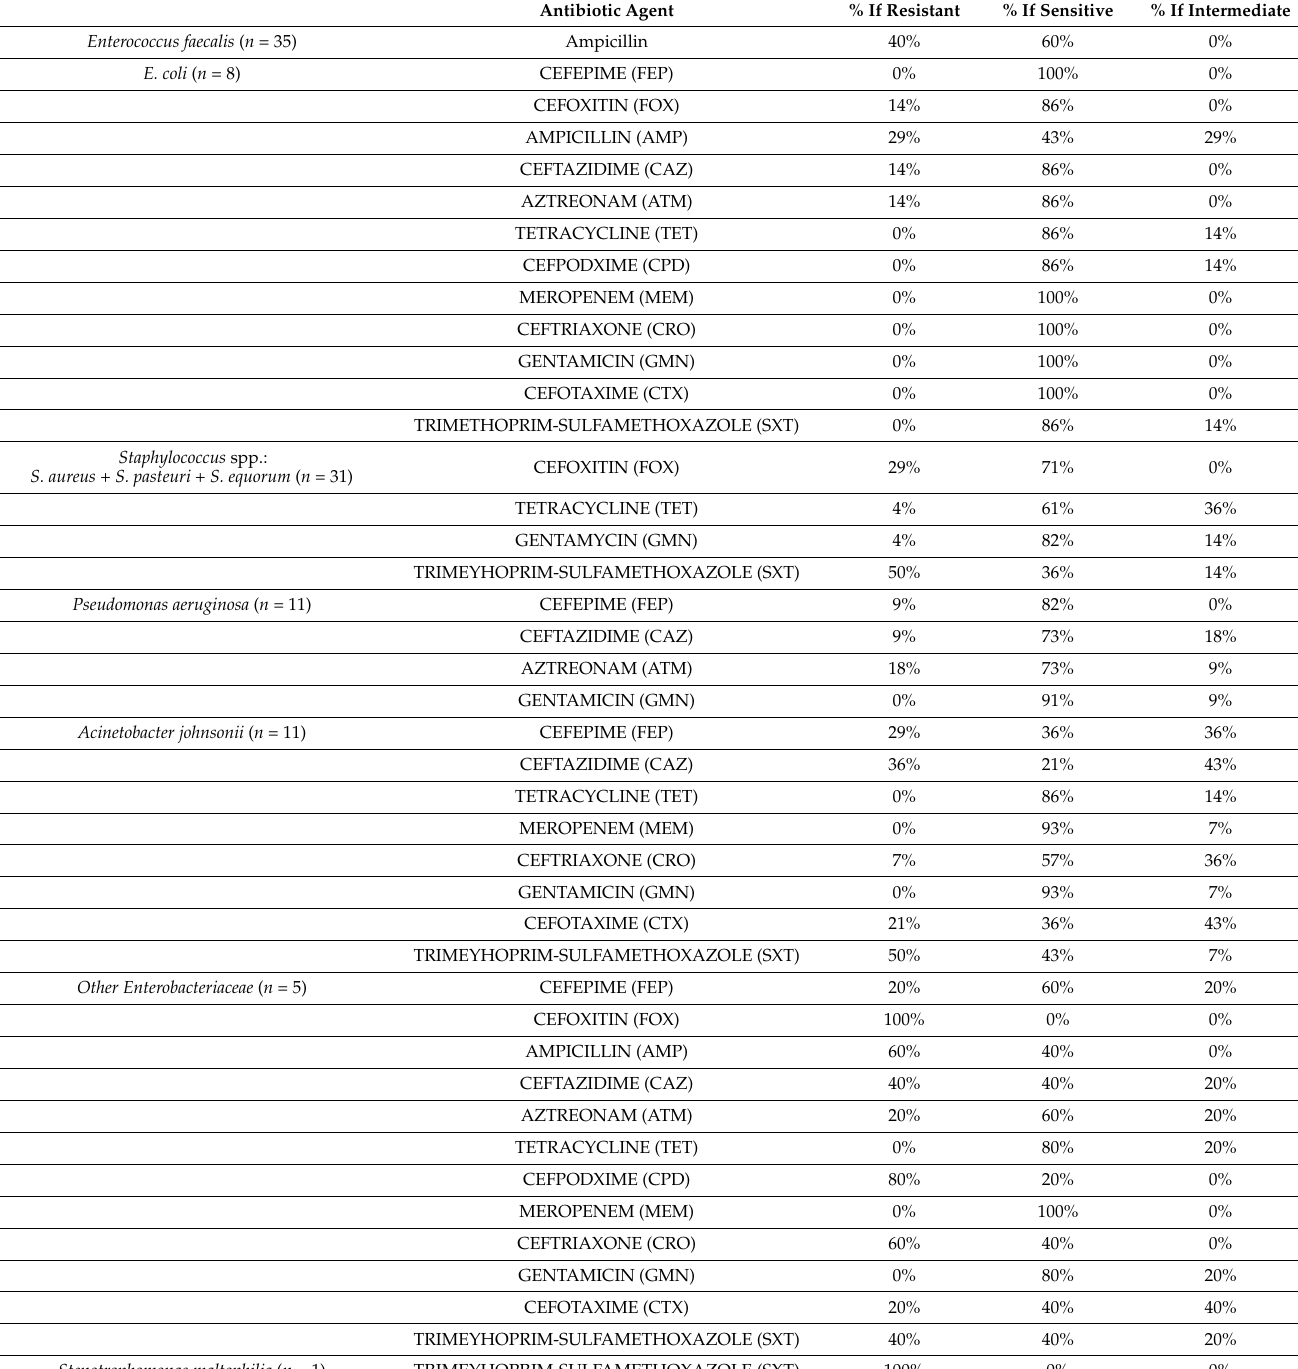
Table 5. Percentages of antibiotic resistance, intermediate and sensitive (susceptible)